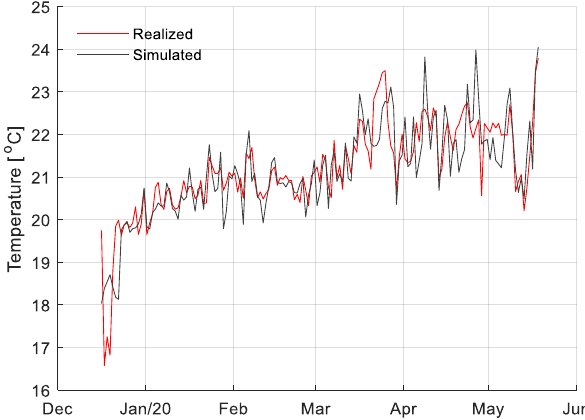
Figure A6. Measured and simulated greenhouse air temperature ( ◦ C) after automated distillation of climate strategies during the experimental period (16 December 2019 until 29 May 2020) for one of the compartments (301).